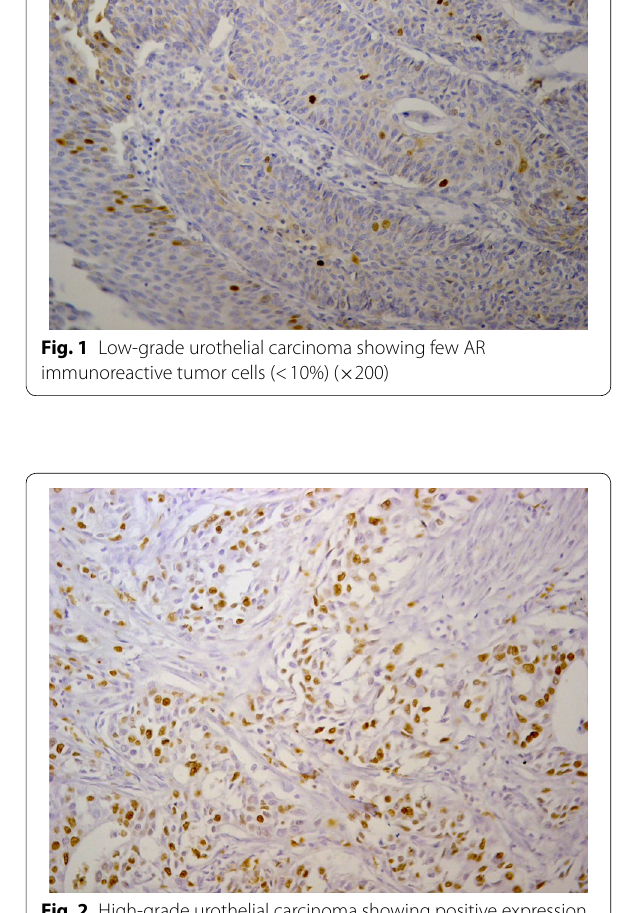
Fig. 2 High-grade urothelial carcinoma showing positive expression of AR (> 10%)